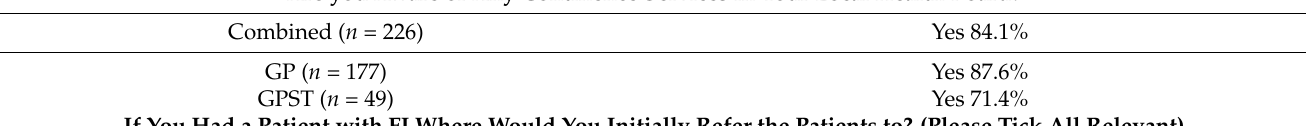
Table 3. Faecal incontinence